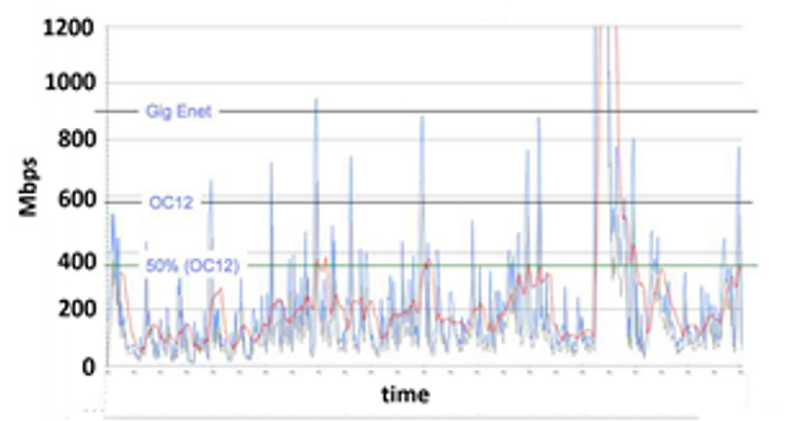
Figure 2. Bandwidth vs. time monitoring of hybrid cloud storage network, illustrating bandwidth spikes on the order of tens of minutes in